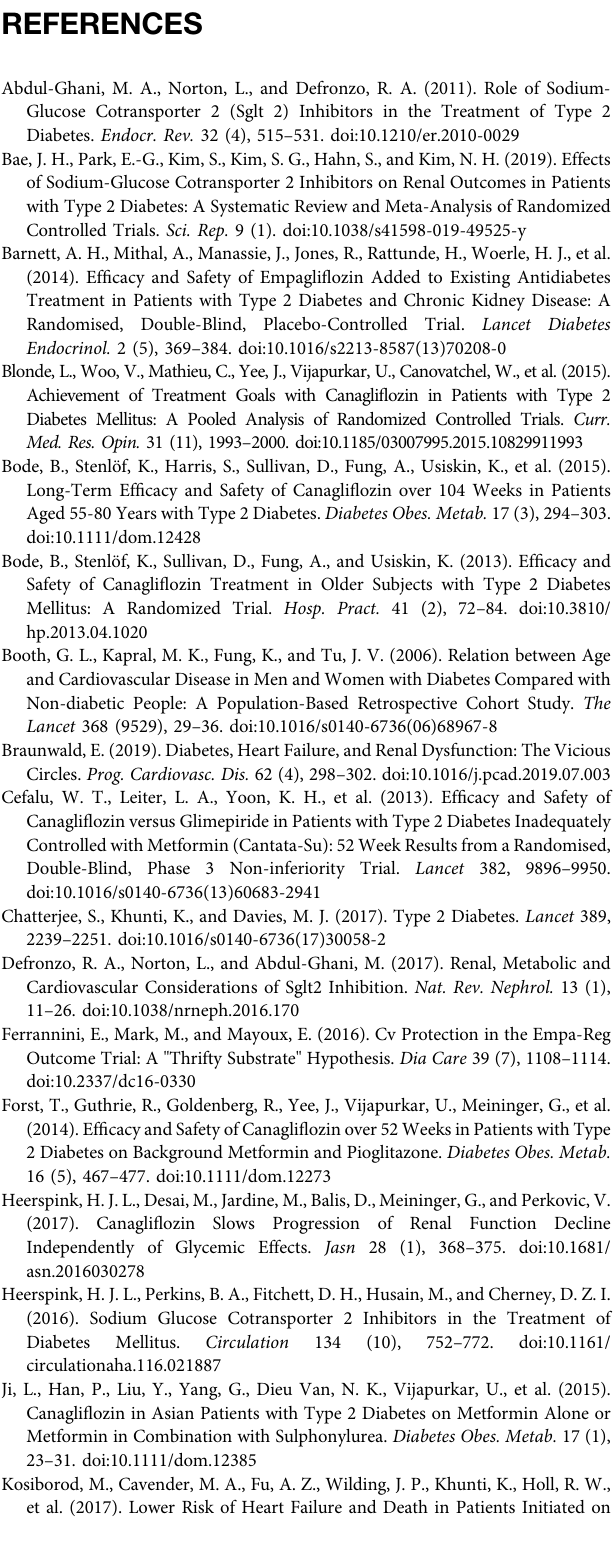
Supplementary Figure 2 | Forest plot of the effect of 100 mg/day canagli fl ozin on the Creatinine of the T2DM after sensitivity analysis of removing one heterogenous